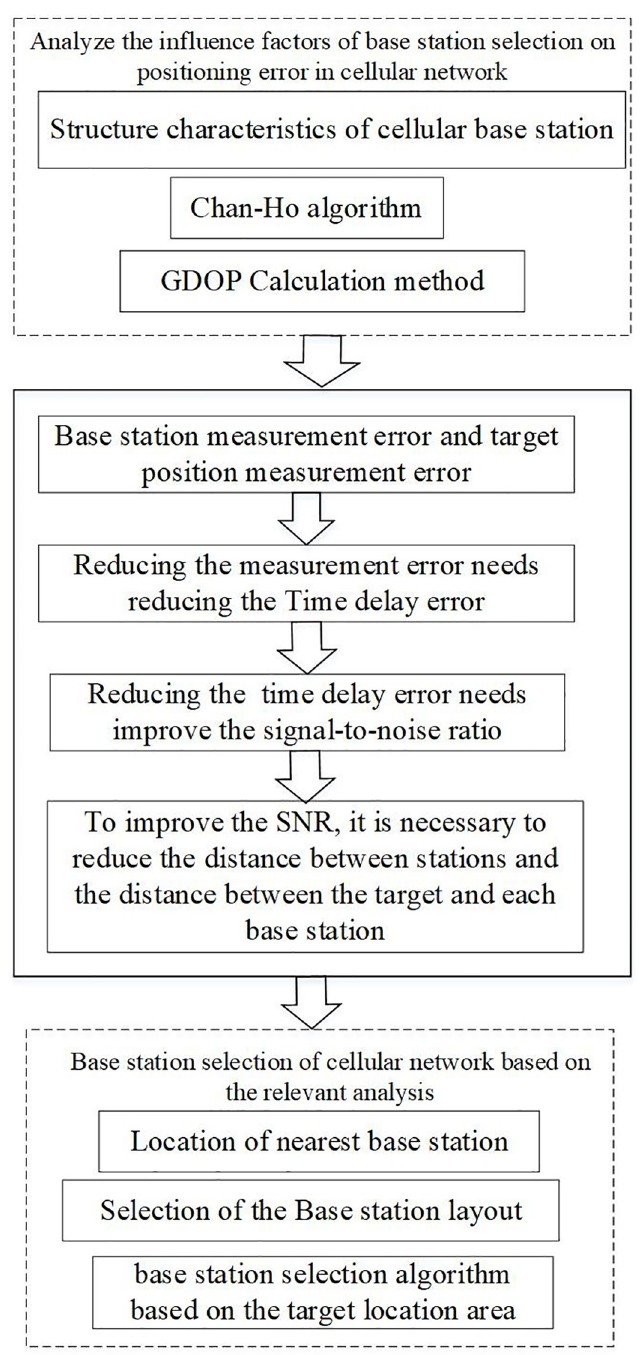
Fig 2. Analysis flow chart of base station selection algorithms in mobile cellular